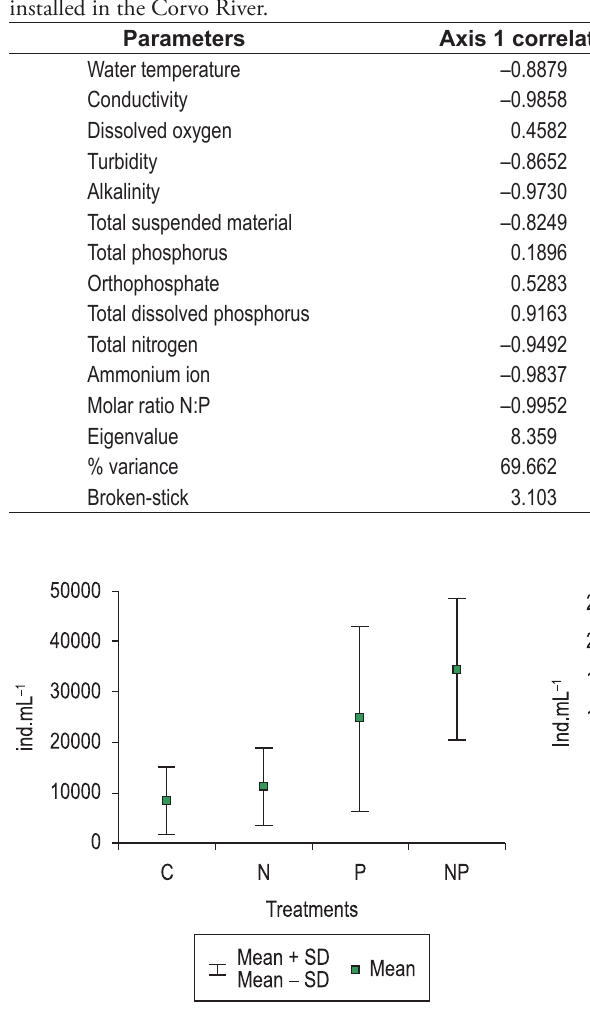
Figure 5. Algal density of the most representative classes in different treatments of mesocosms installed in the Corvo river (Rosana reservoir). Control treatment (C); nitrogen treatment (N); phosphorus treatment (P) and nitrogen plus phosphorus treatments